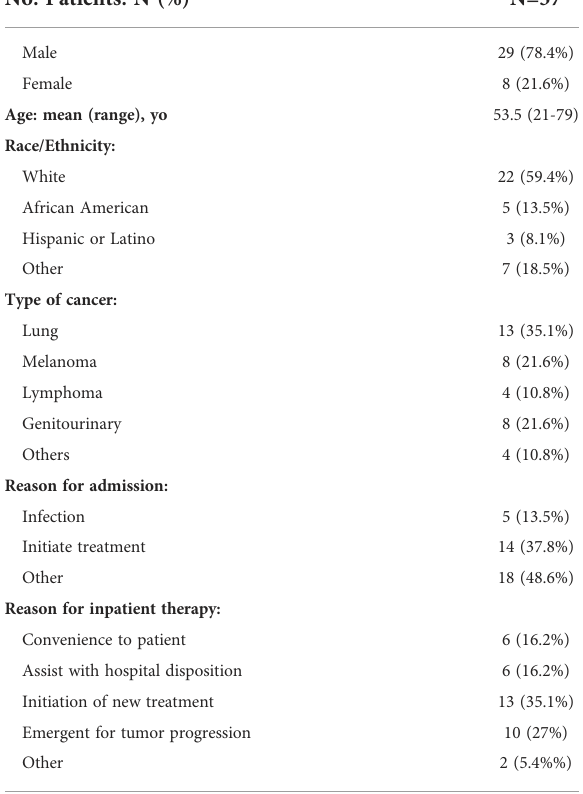
TABLE 1 Hospitalized patient demographics and